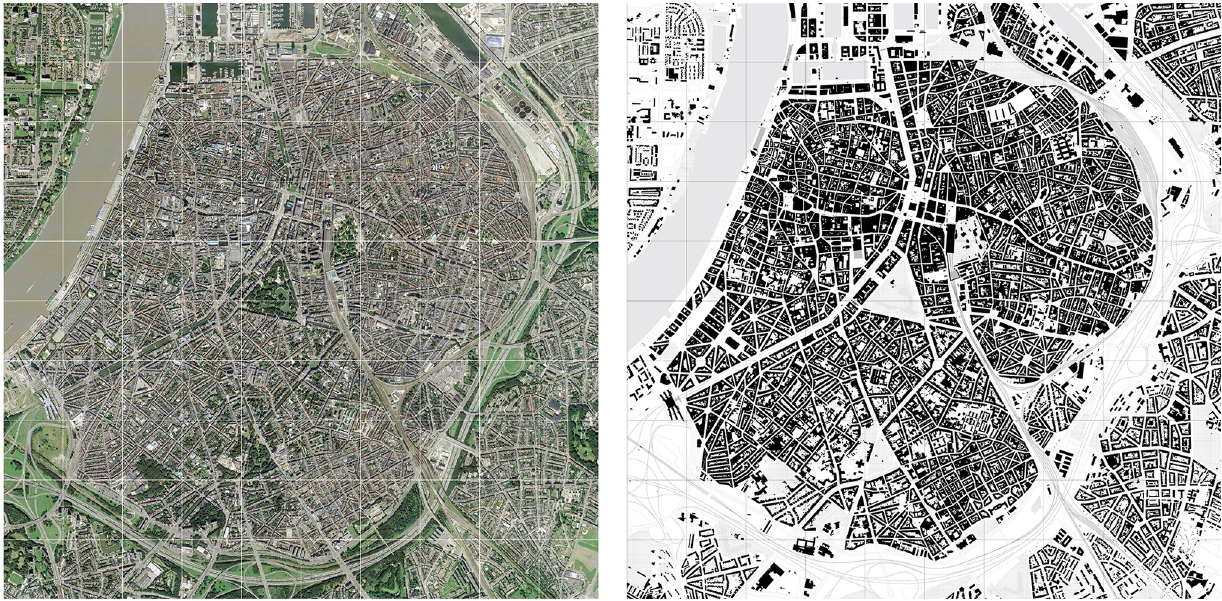
Figure 3. Area of 5 × 5km of Antwerp, city and subject of the ‘Analogue City’ workshop. Left: Aerial picture. Source: Google Earth. Right: Urban footprint. Source: Geopunt